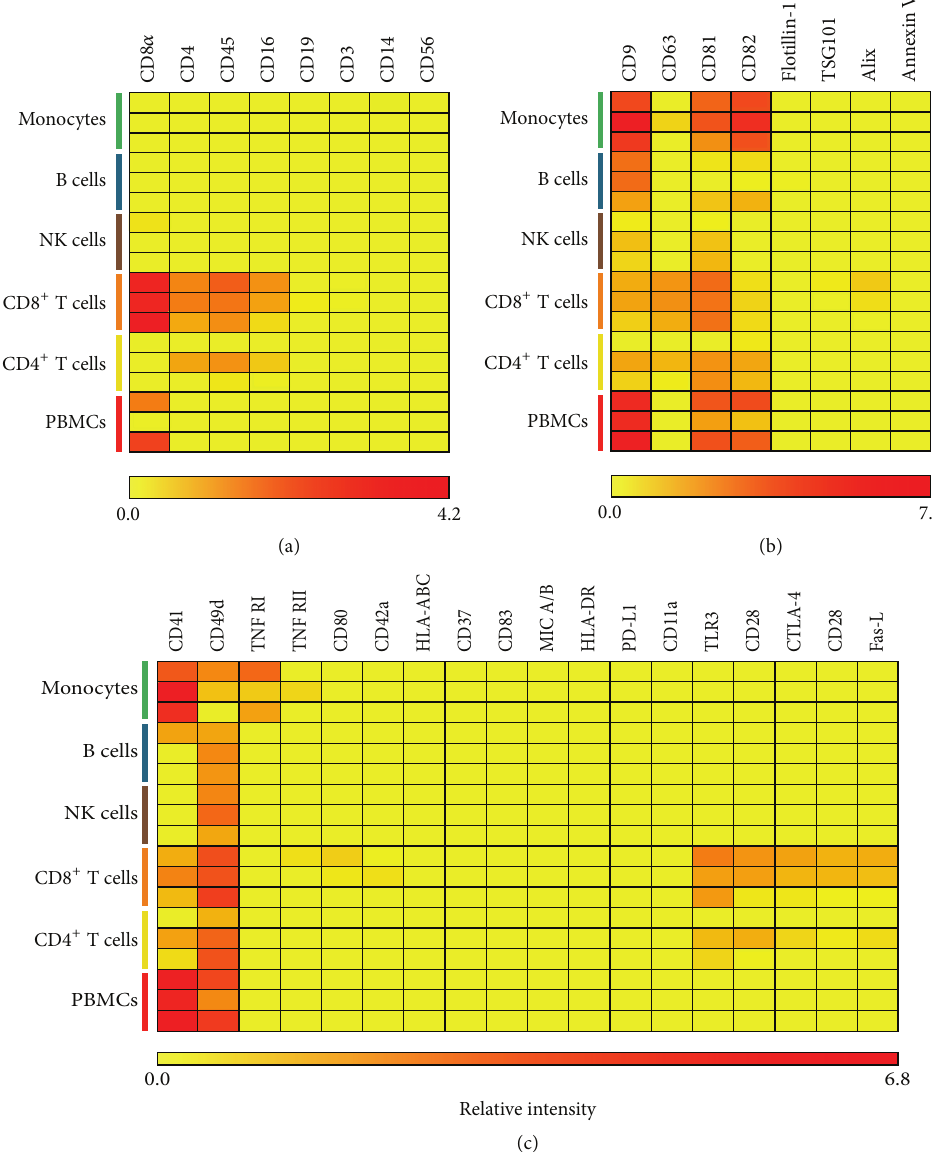
Figure 1: Phenotyping of the different subsets of leukocyte-derived sEVs. The different subsets of leukocyte-derived sEVs were phenotyped for a panel of selected markers using the EV Array. The sEVs were captured by antibodies targeting the selected markers and subsequently detected by addition of an antibody cocktail against CD9, CD63, and CD81. The heat maps illustrate the results from each of the three independent experiments divided into lineage-specific markers (a), vesicle-related markers (b), and general immunological markers (c) and present the relative intensities of each of the markers as indicated by the colored bars. Data are presented as the mean value of the triplicates.